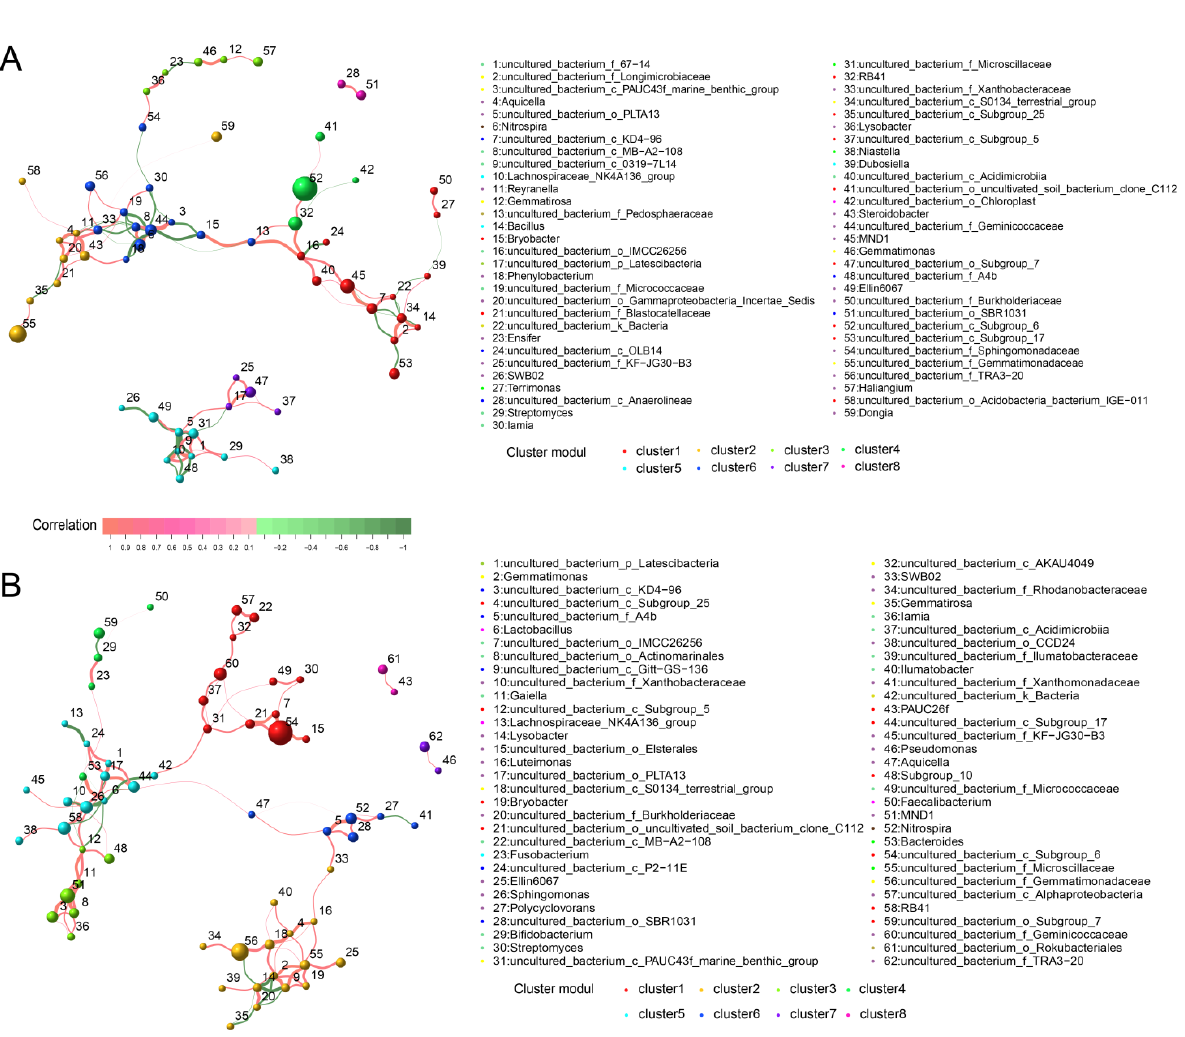
Figure 11. Co-occurrence network of bacteria. Each node represents a type of bacteria. The size of the nodes represents the relative abundance of the bacteria. The edges indicates the presence of an ecological correlation. The red edge indicates positive correlation. The green edge represents negative correlation. The thickness of the edge indicates the level of correlation. Bacteria of the same cluster are shown in the same color. The bacteria names are shown on the right. ( A ) 0 – 20 cm soil. ( B ) 20 – 40 cm soil.